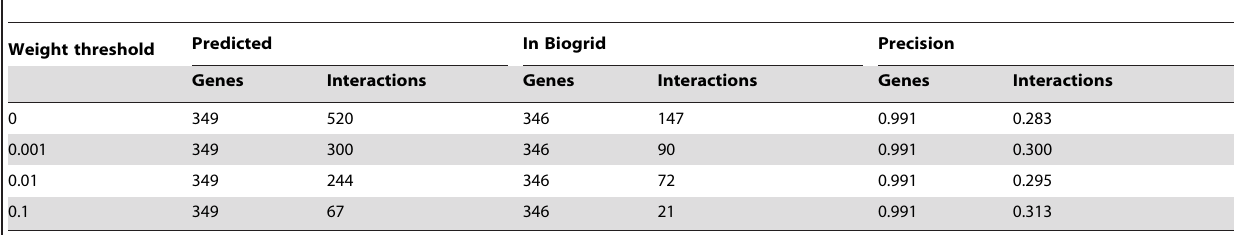
Table 6. Precision of yeast interactions.